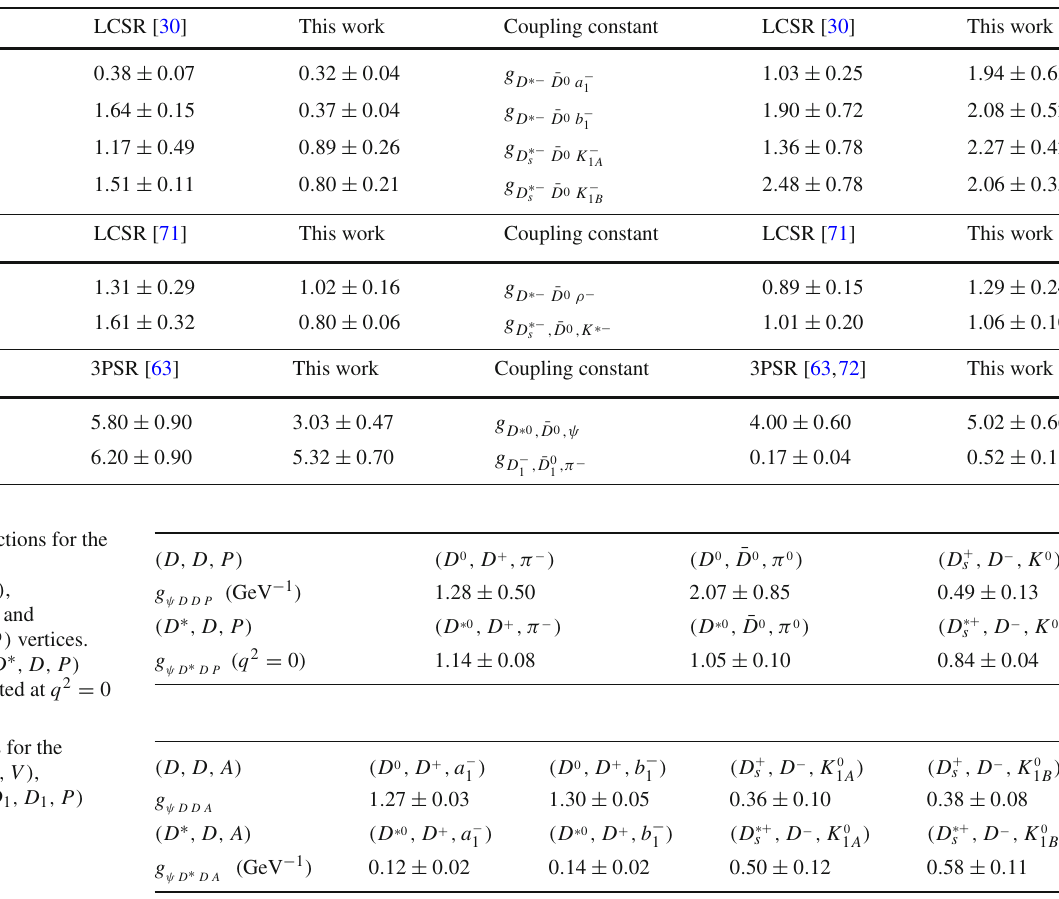
Fig. 4 The strong coupling constants g uncertainty